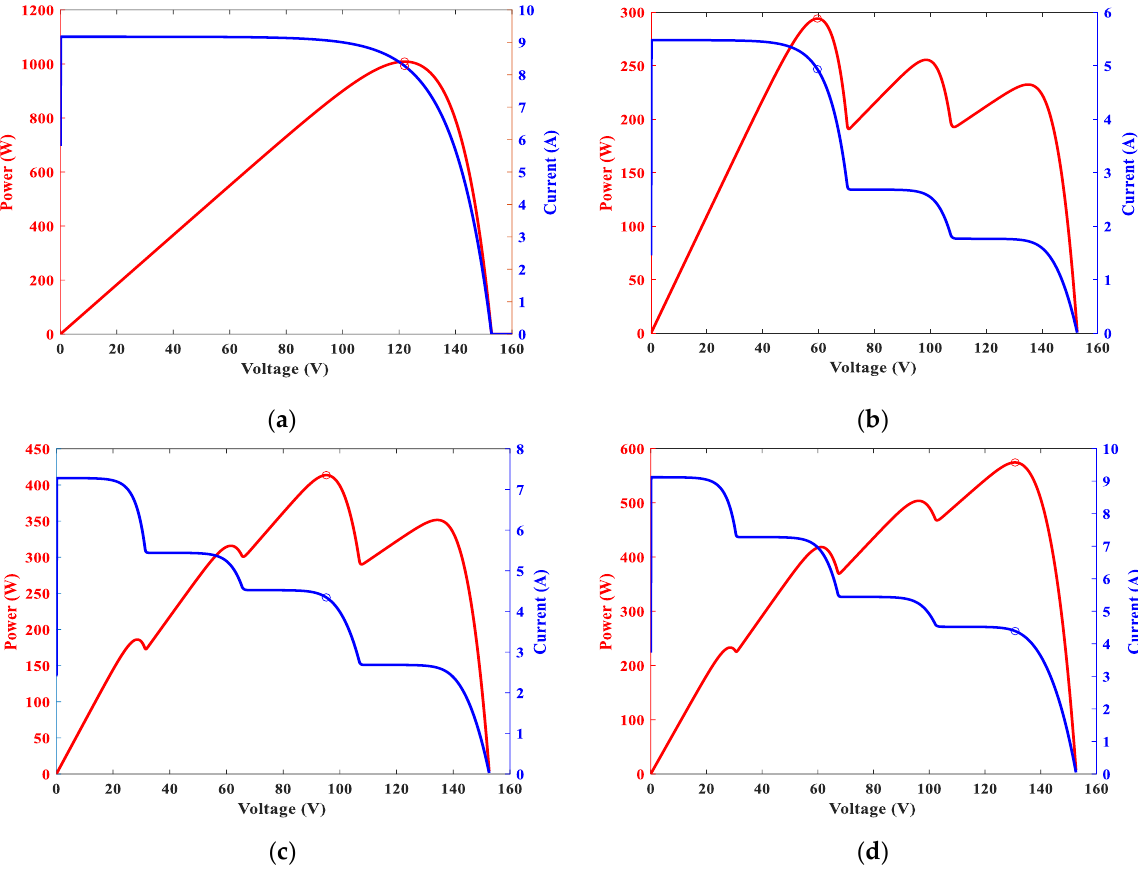
Figure 6. P-V and I-V characteristic curves of the four-shading pattern applied separately in this study: ( a ) shading pattern#1; ( b ) shading pattern#2; ( c ) shading pattern#3; and ( d ) shading pattern#4.